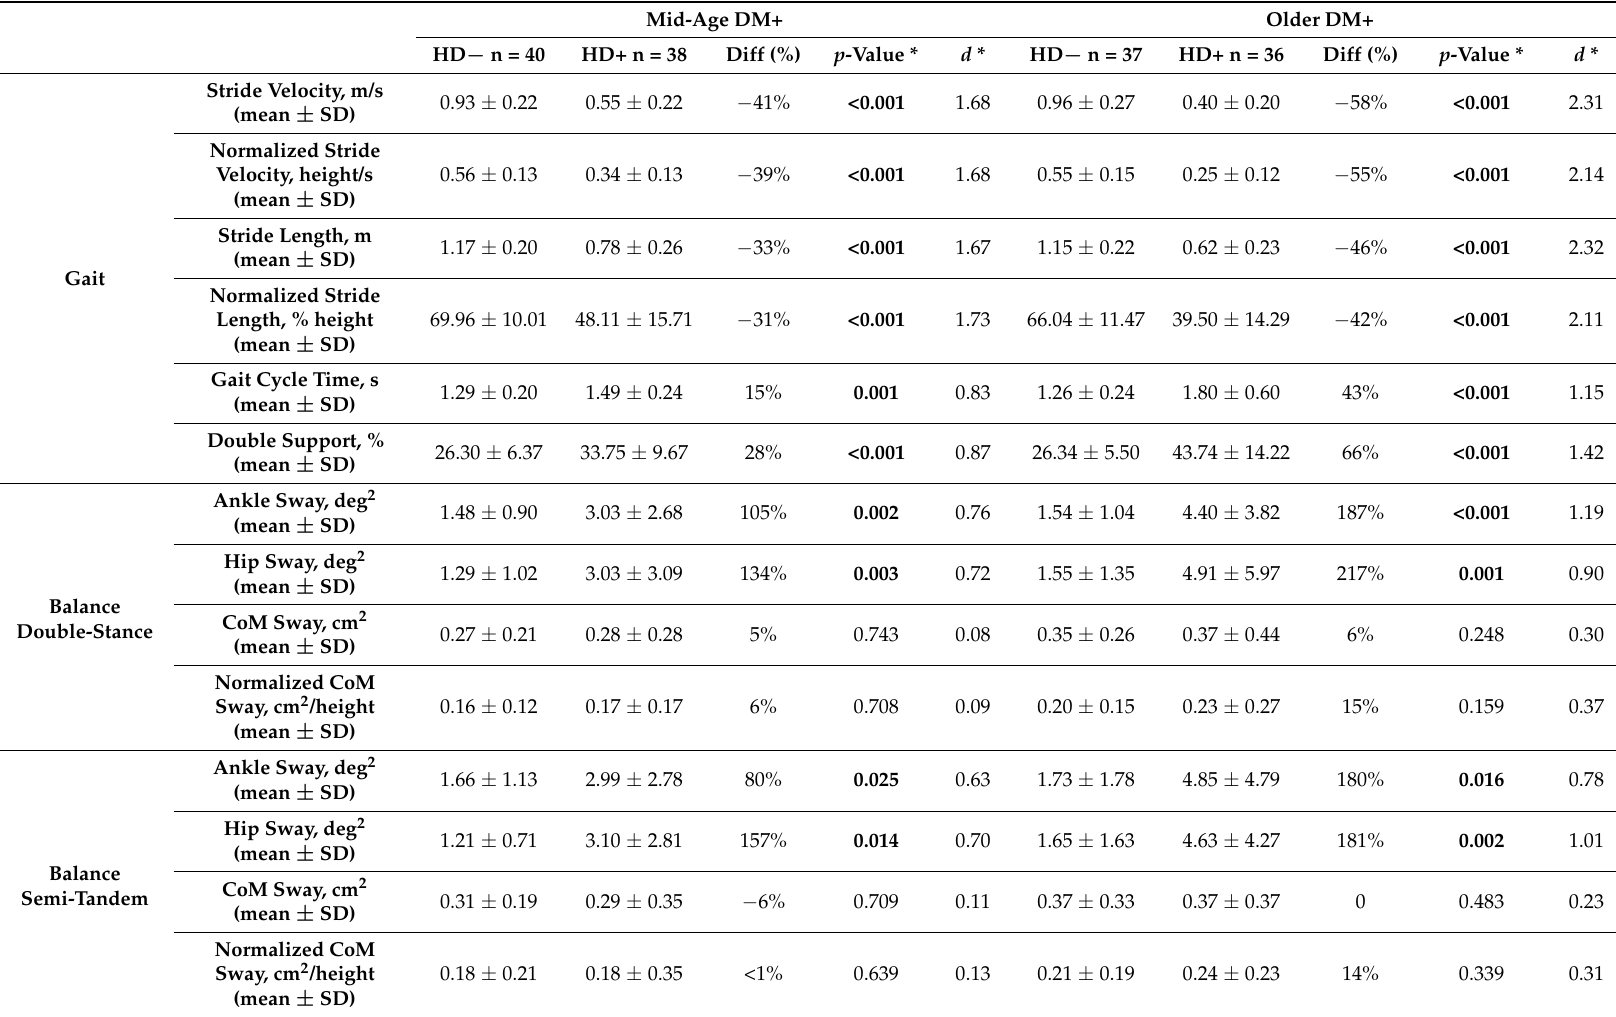
Table 3. Between-group comparison for gait and balance performance among Mid-age HD − , Mid-age HD+, Older HD − , and Older HD+